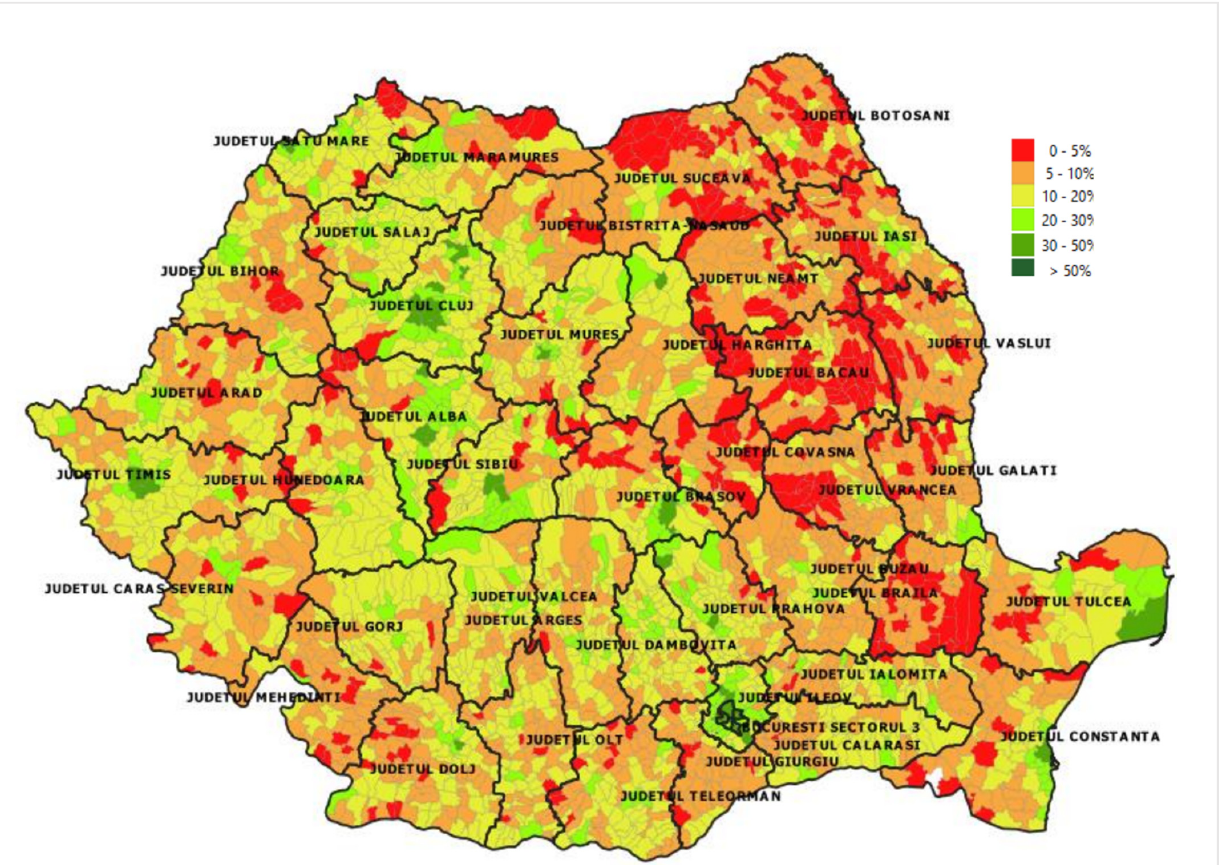
Figure 7. COVID-19 vaccination coverage (at least one dose) in Romania by administrative territorial unit on 31 May 2021, data generated from the National Electronic Registry of